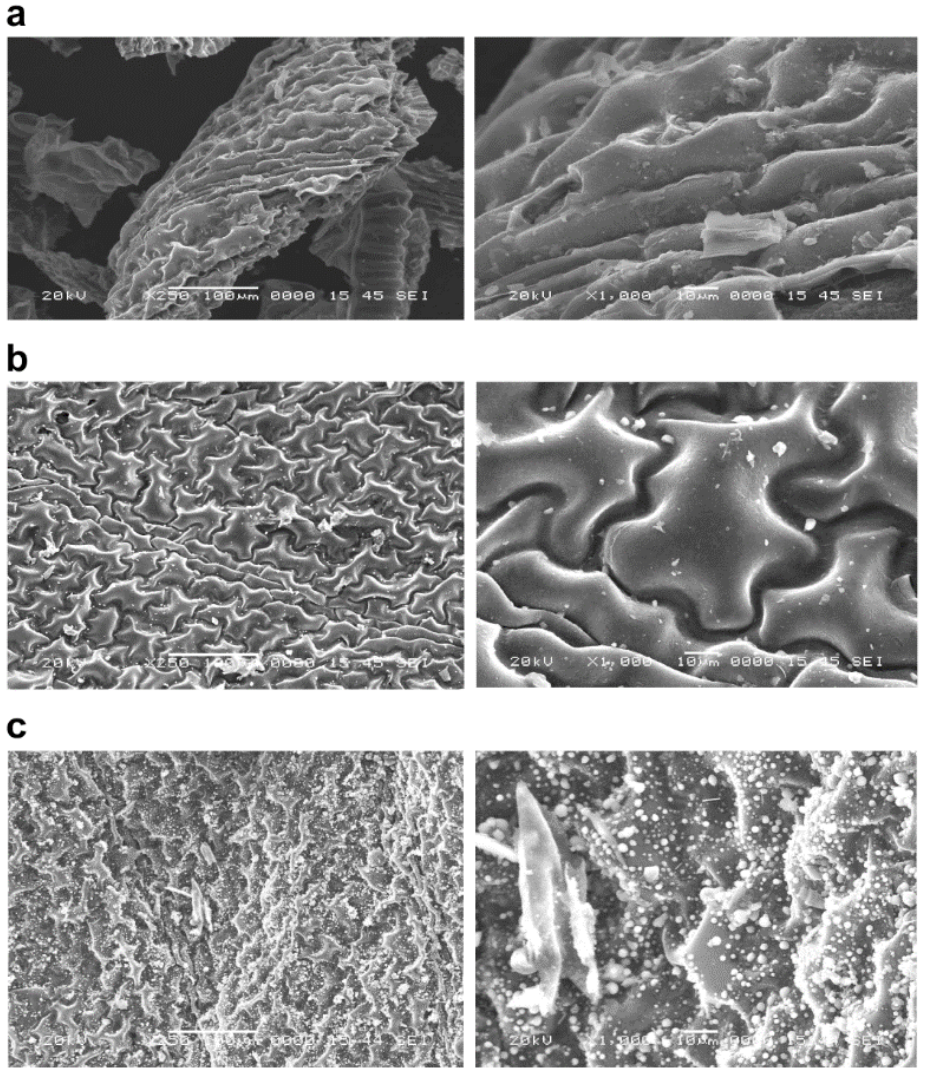
Figure 1. The surface structure of P. vittata biochar by SEM observation. Left column: Magnifica- tion 250 × ; Right column: Magnification 1000 × ; ( a ) Pyrolysis temperature: 600 ◦ C; ( b ) Pyrolysis temperature: 800 ◦ C; ( c ) Pyrolysis temperature: 1200 ◦ C.